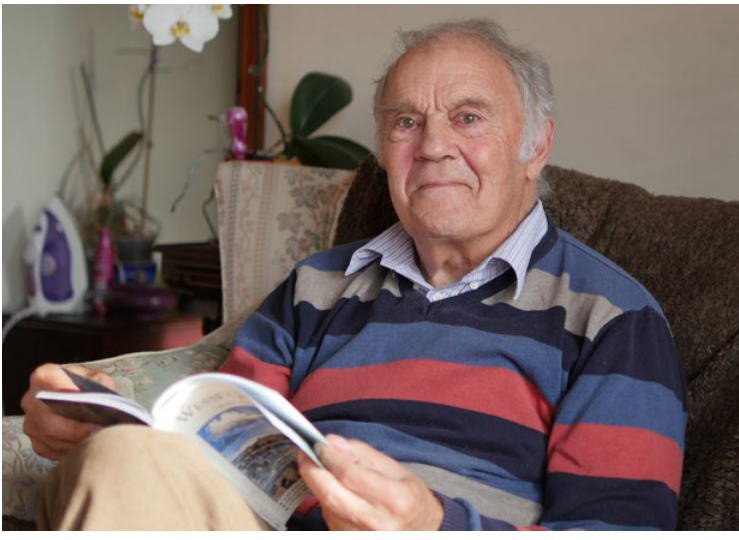
Figure 5.2 Colin House at home in Weymouth in